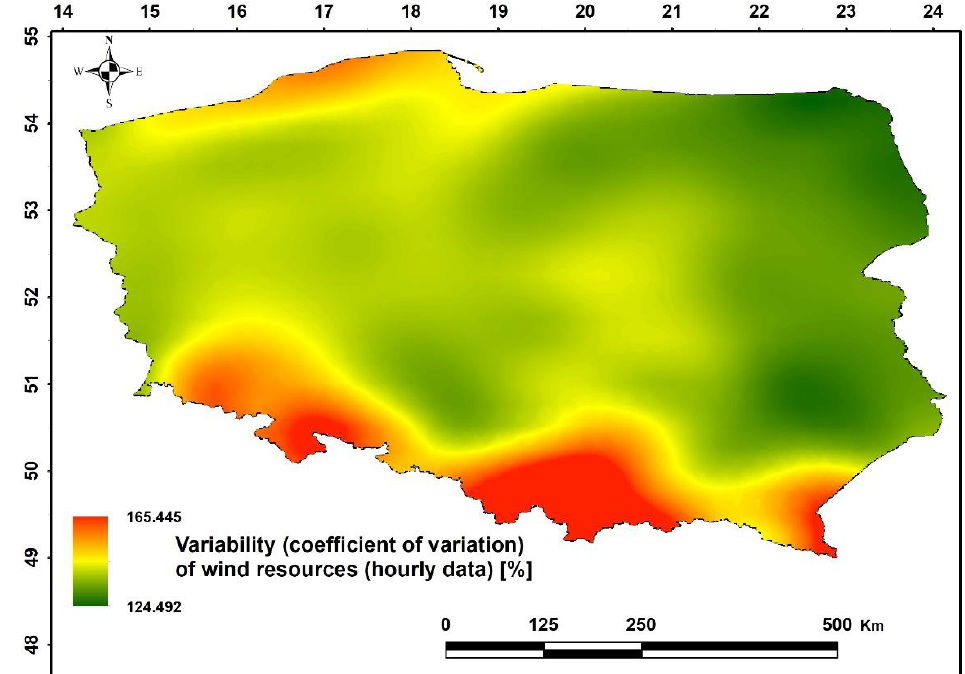
Figure 12. Wind resources coefficient of variation, 1980 – 2019.